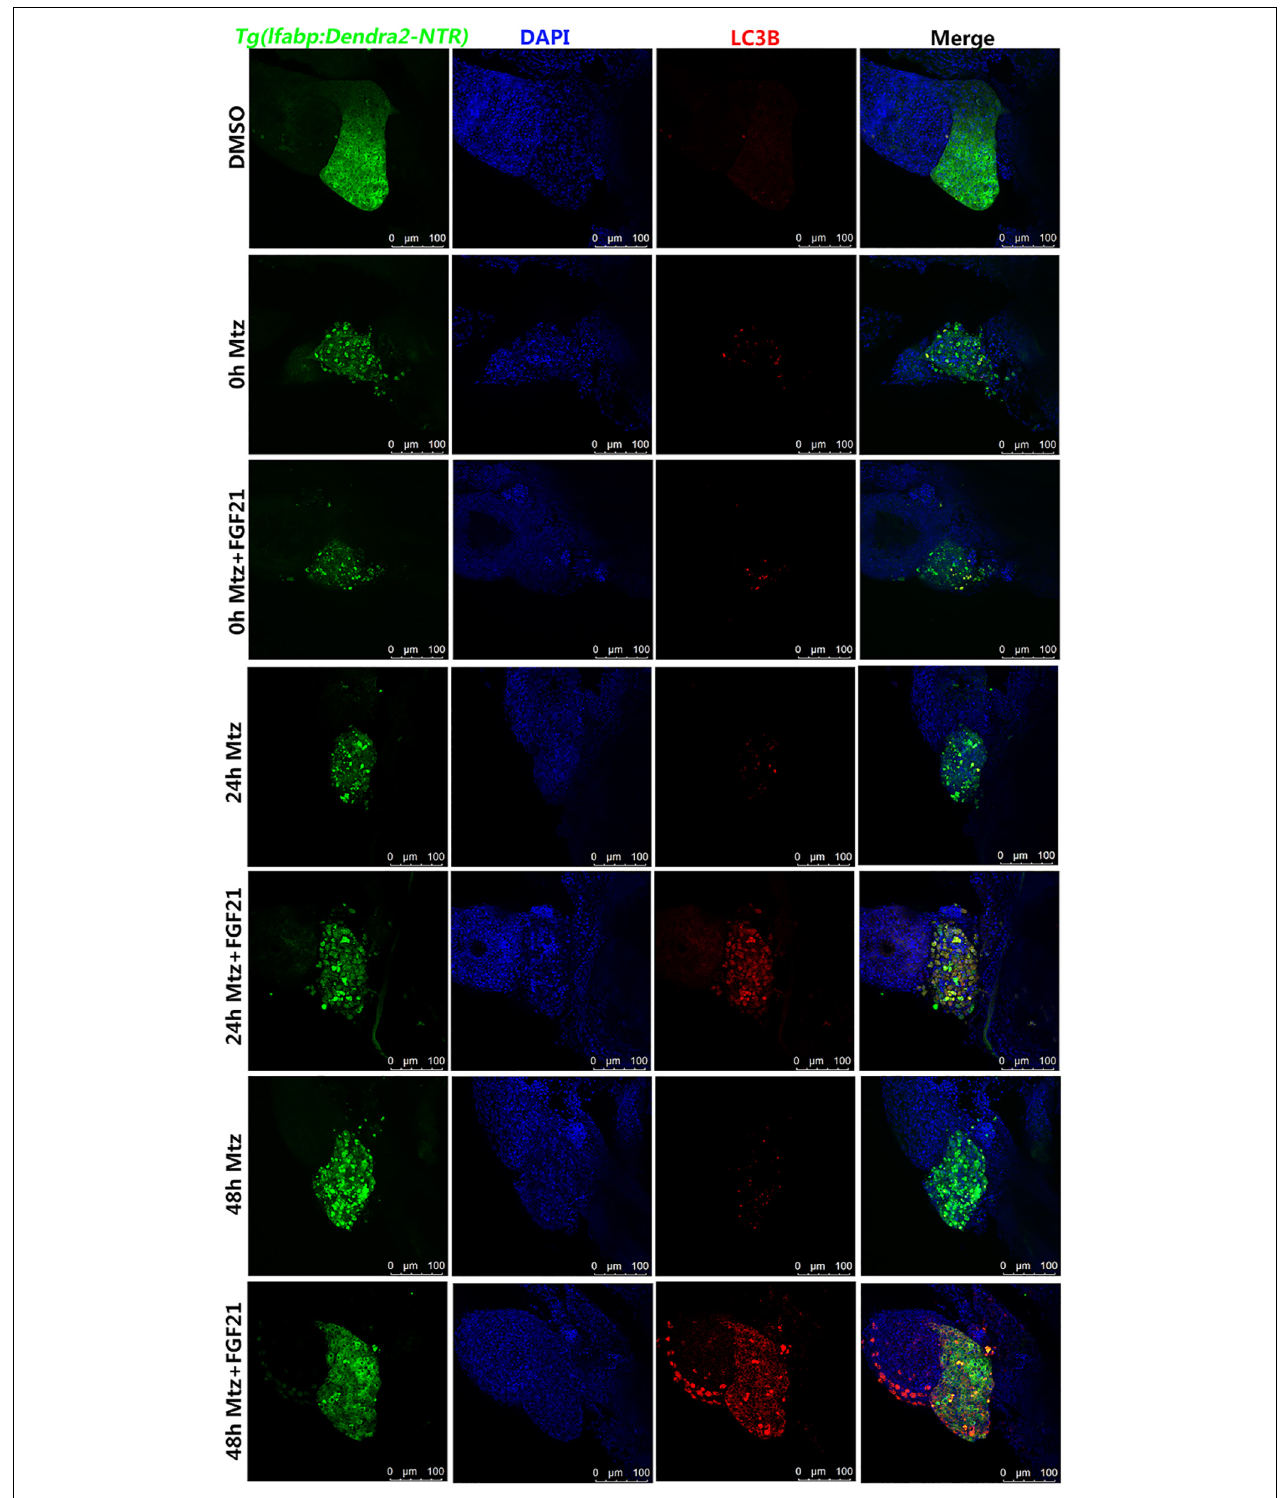
FIGURE 5 | Fibroblast growth factor 21 promotes autophagy after liver injury. Samples were collected at 0, 24, and 48 hpa for the evaluation of autophagy. LC3B assay was performed to assess the level of autophagy in the damaged liver. Liver cells (green fluorescent Denra-NTR), stromal cells (blue fluorescent DAPI), and autophagy positive cells (red fluorescent LC3B). DMSO group: without Mtz treatment, DMSO was applied. Mtz group: after Mtz treatment, grow naturally. Mtz+FGF21 group: after Mtz treatment, treated with FGF21 standard protein ( n = 40 per group, repeat 3 times for each test). Scale bar = 100 µ m.